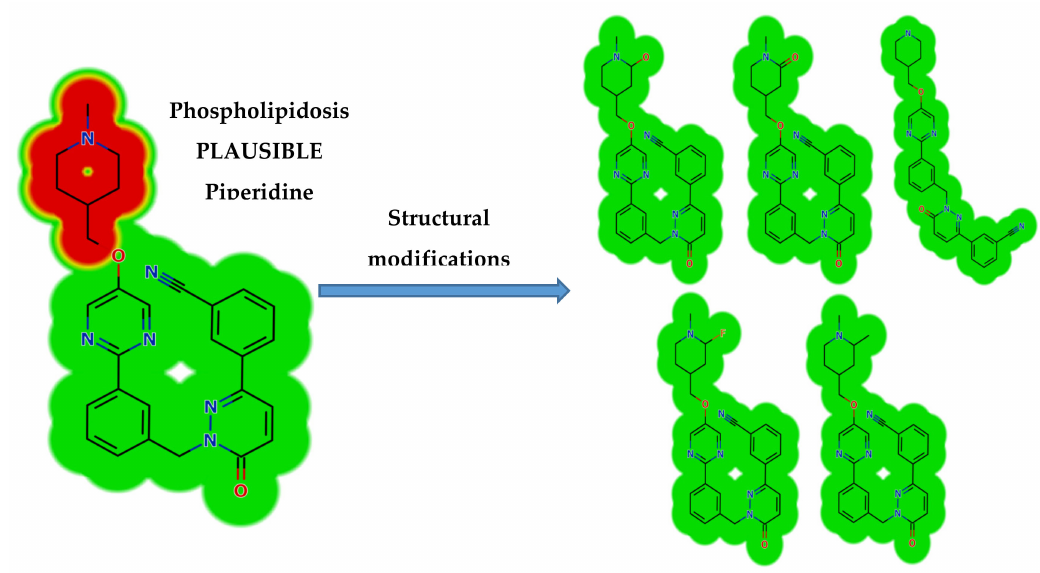
Figure 6. DEREK module of StarDrop software displaying the disappearance of phospholipidosis structural alert due to small structural modification in the N -methyl piperidine ring that matched the proposed bioactivation